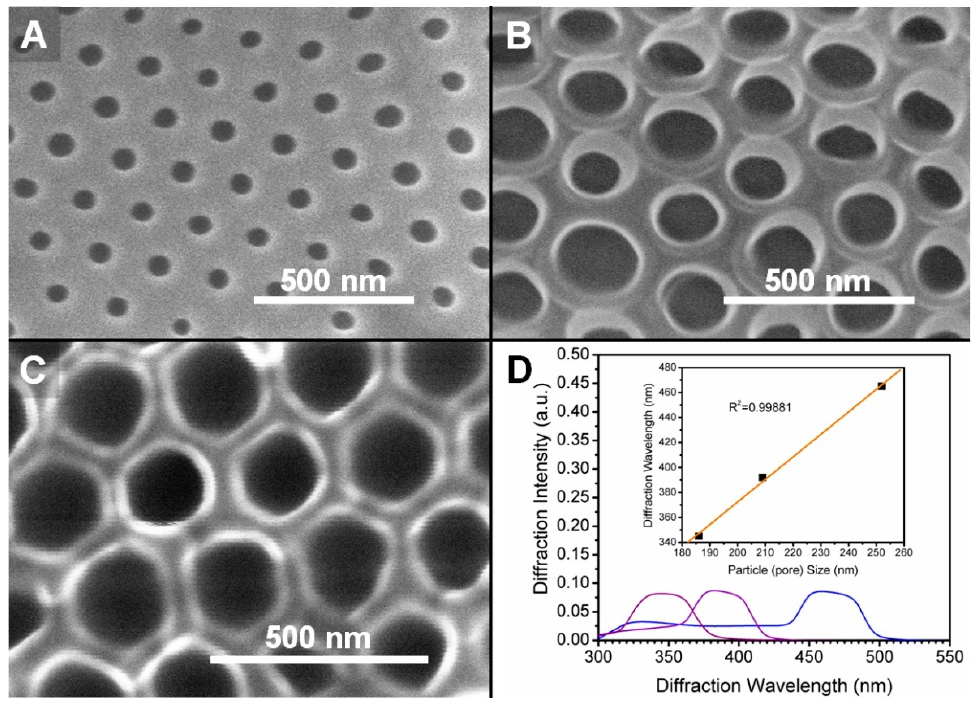
Figure 5. SEM photos of PVA IOCs after etching PS templates with different diameters: ( A ) 186 nm, ( B ) 209 nm, ( C ) 252 nm. ( D ) The diffraction spectrum of PVA IOCs. The insert is the relationship between the diameter of PS nano-colloids and the PBG of IOC.